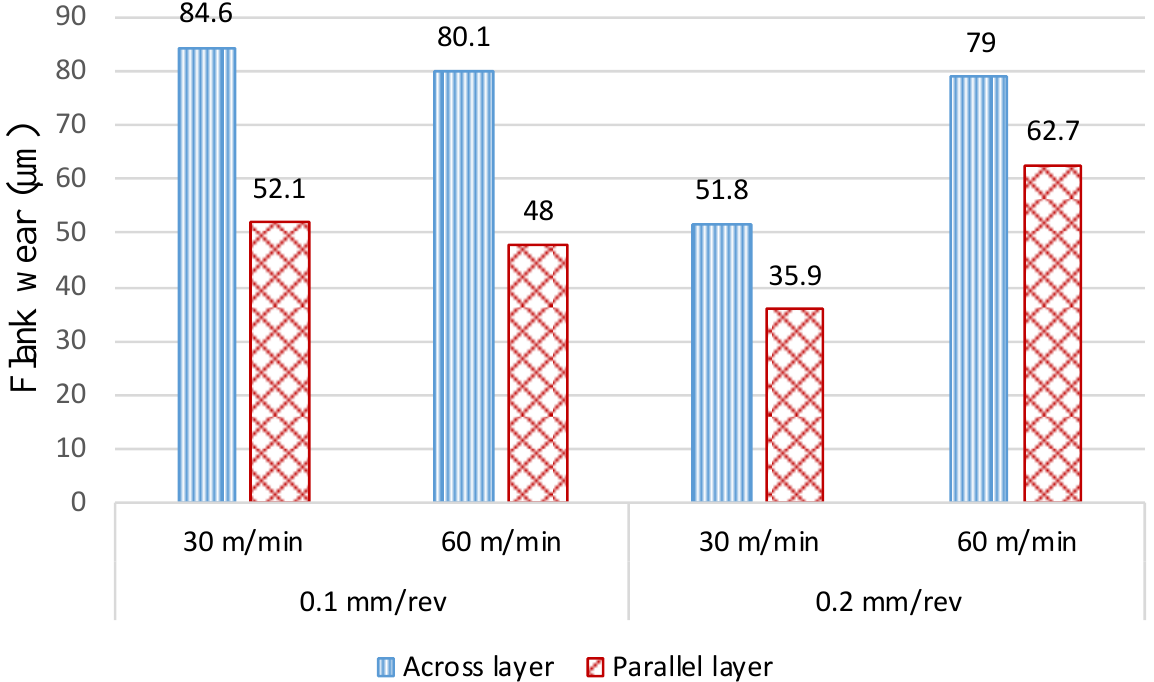
Figure 12. Flank wear measured for AL orientation and PL orientation at V = 30 m/min and 60 m/min, f = 0.1 mm/rev and 0.2 mm/rev, and d = 0.2 mm.